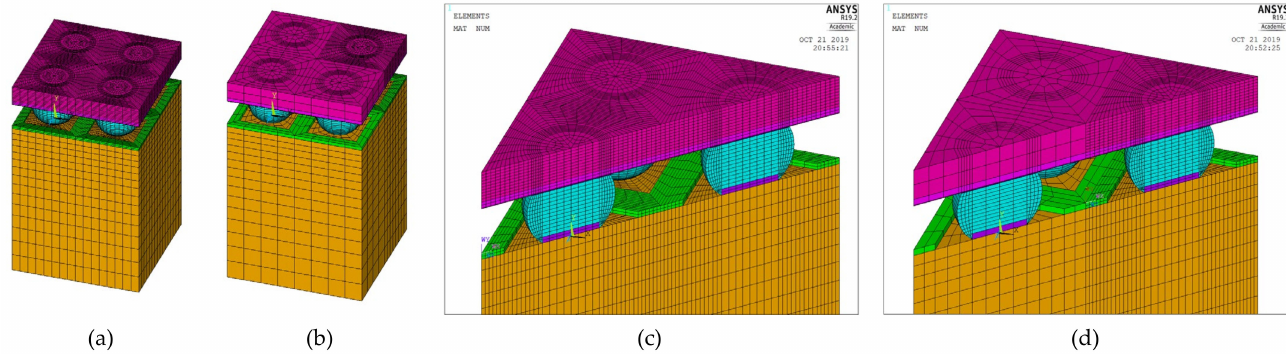
Figure 9. Three-dimensional (3D) finite element model: ( a ) Full fine-mesh model; ( b ) multipoint constraint (MPC) model; ( c ) cross-section view of the full fine-mesh model; ( d ) cross-section view of the MPC model.